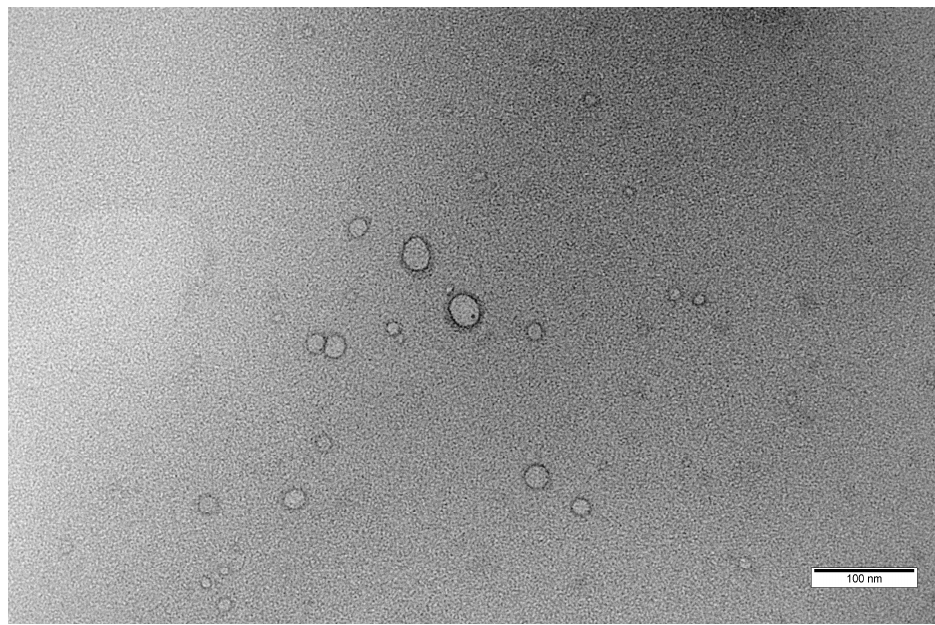
Figure 3. Conventional TEM image of the blank polymersomes formed at pH 7.4 with a polymer concentration of 5 mg·mL −1 (scale bar = 100 nm).